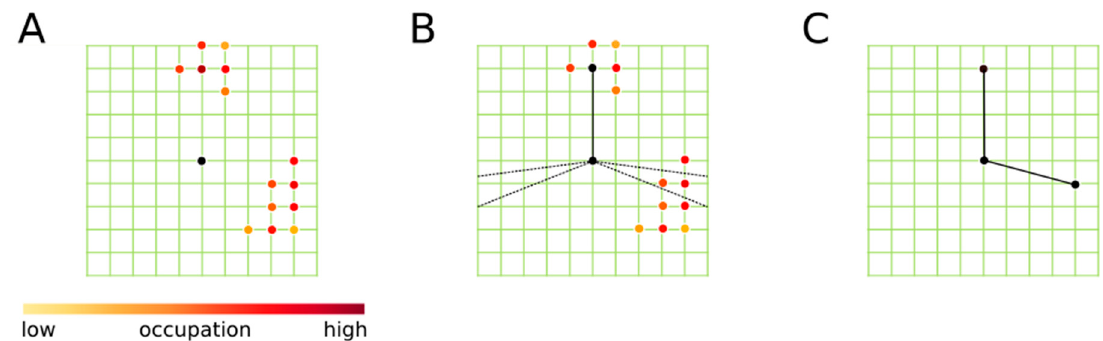
Figure 2. Schematic representation of the hydrogen-positioning algorithm. ( A ) The black center dot represents the oxygen atom, whereas the color-coded dots represent the occupation number of the protons on the grid. ( B ) Placement of the first proton at the highest grid occupation. To obtain a reasonable water geometry with an H–O–H angle of 104.5 ± 5.0°, the position of the second proton is limited to the space in between the dotted lines, which corresponds to a spherical segment in three dimensions. ( C ) Resulting water orientation.